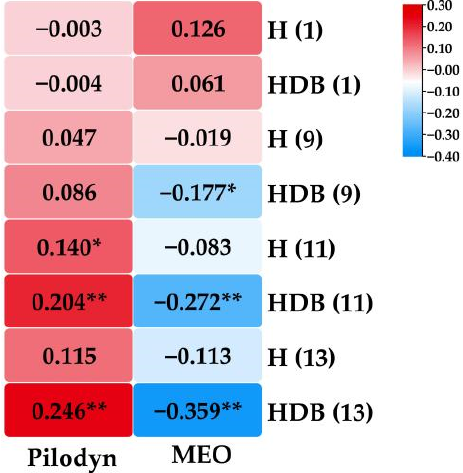
Figure 3. Correlation analysis between growth characteristics and wood properties of C. fargesii clones. Pilodyn, Pilodyn value; MEO, elastic modulus. * Represents correlation is significant at the 0.05 level, and ** represents correlation is significant at the 0.01 level.